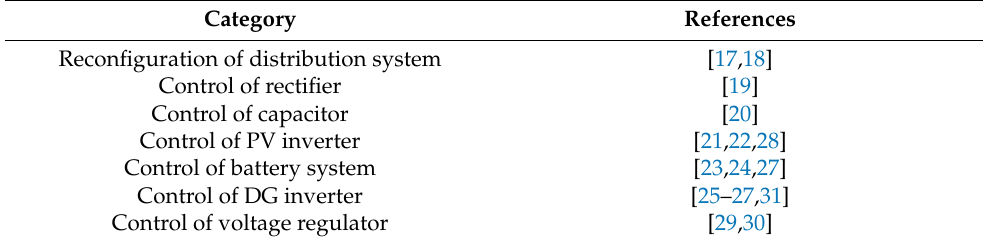
Table 1. Summary of survey on voltage unbalance